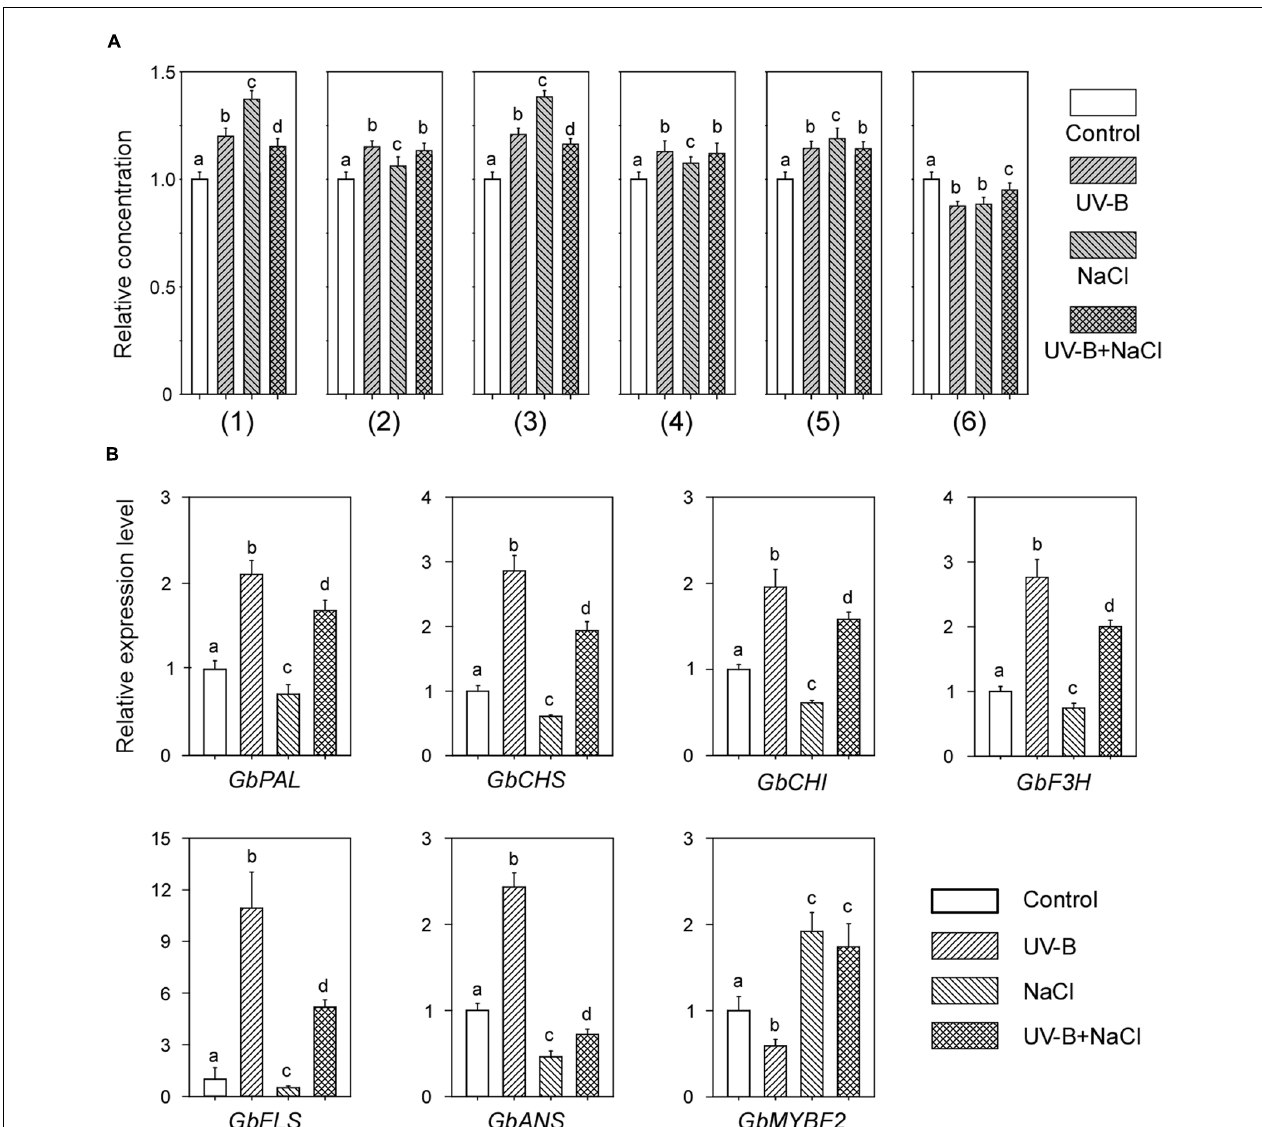
FIGURE 4 | Combined UV-B and NaCl treatment have no additive effect on the flavonoid contents in post-harvest Ginkgo leaves. (A) Relative flavonoid contents after individual or combined treatment with UV-B and NaCl. (B) Relative expression levels of flavonoid biosynthesis related genes after individual or combined treatments with UV-B and NaCl. Different letters indicate significant differences ( P < 0.01; Tukey’s test). Data for independent experiments are shown (mean ± SD; n =